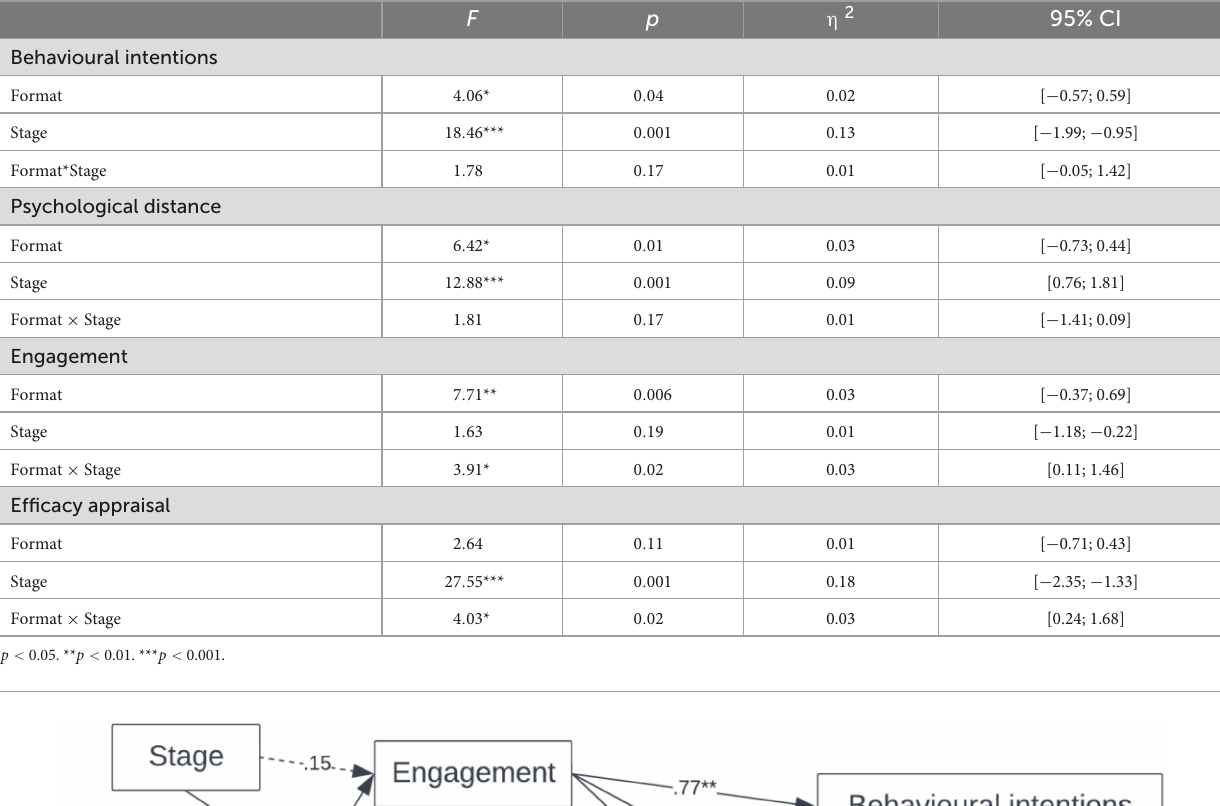
TABLE 2 MANOVA–influence of format and stage of behavioural change (Study 2).